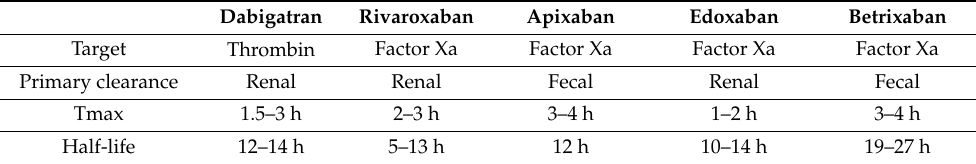
Figure 4. The inhibition mechanisms of direct oral anticoagulants (DOACs). Dabigatran is direct thrombin inhibitor, other DOACs including rivaroxaban, apixaban, edoxaban, and betrixaban are direct factor Xa inhibitors. DOACs inhibit coagulation factors directly. On the other hand, heparin indirectly inhibits coagulation factors through AT and warfarin affects to the coagulation factor synthesis. Table 1. The characteristics of